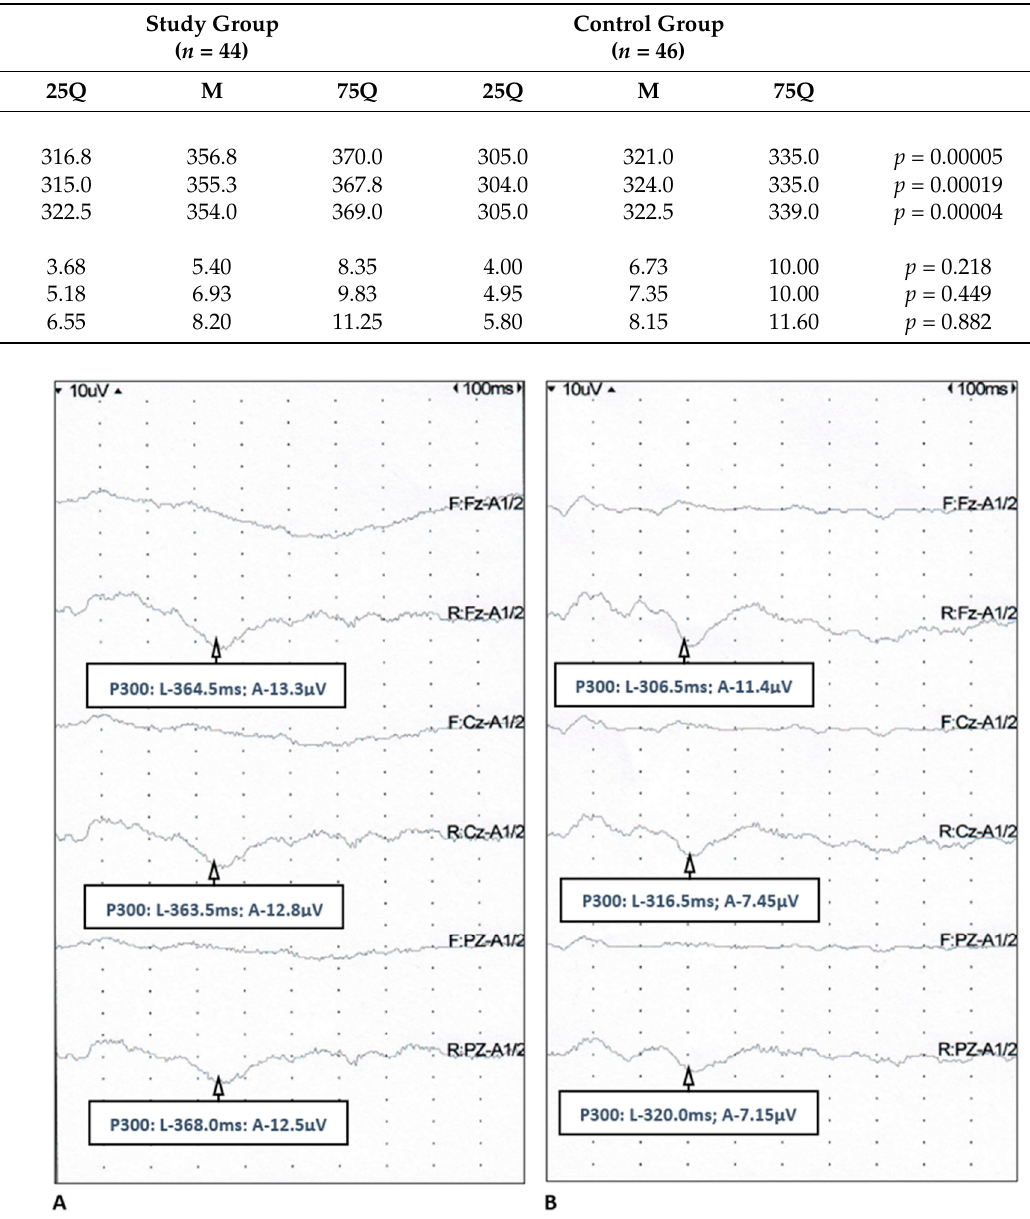
Table 4. Comparison between P300 parameters in the study group and control group (25Q—25th quartile;